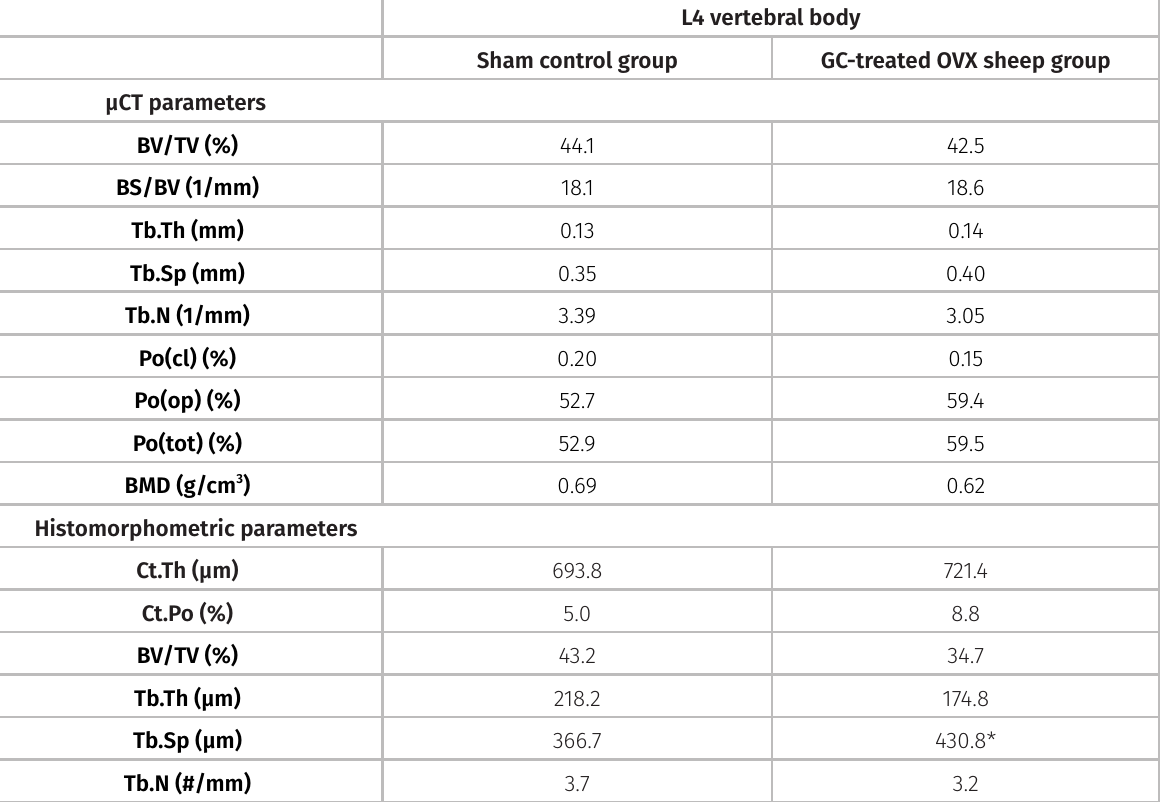
Figure 1. Representative micro-computed tomography 3D reconstructions of L4 vertebral bodies from (a) the sham control and (b) GC-treated OVX sheep groups at the 24 th postoperative Table IV. Micro-architectural parameters and trabecular BMD obtained by µCT and by histomorphometric analysis from the L4 vertebra of both groups in study (median values).